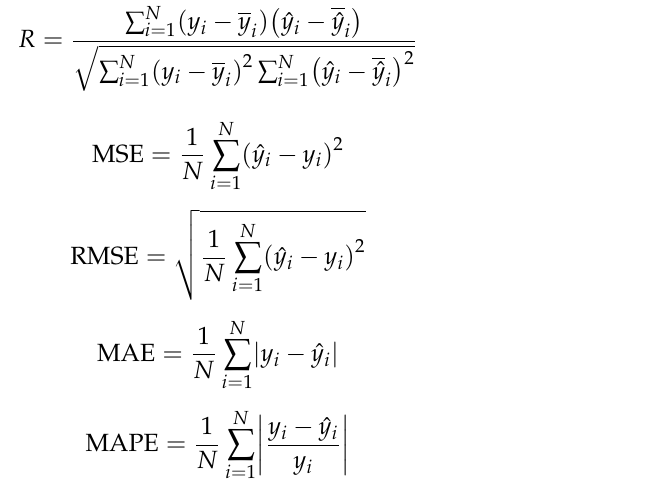
Table 9. R, MSE, RMSE, MAE, and MAPE of Model 7 for training, validation, and test phase. Phase R MSE RMSE MAE MAPE